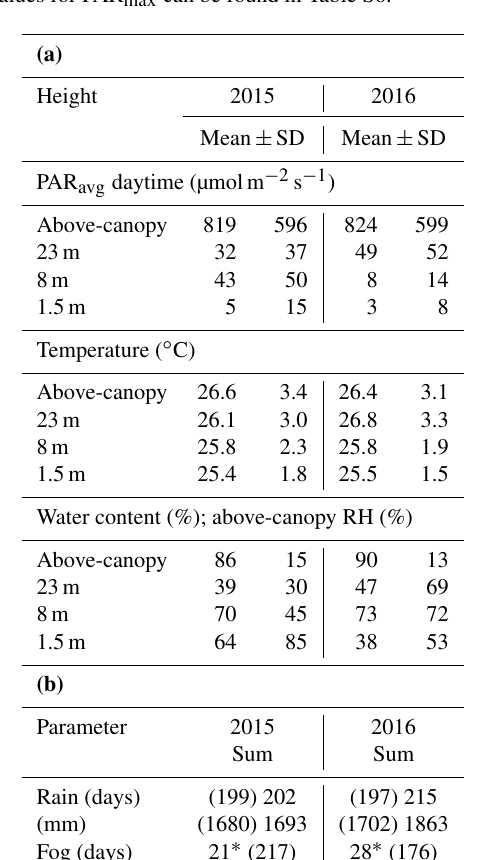
Table 1. Annual mean values and standard deviations ( ± SD) of mean daytime photosynthetically active radiation (PAR avg ), tem- perature, and water content (WC) of bryophytes at the three height levels and above the canopy (a) . Annual sum of rain and fog days as well as the annual sum of rain (b) . Mean values were calculated from 30min intervals. Due to data gaps in the measured rain (shown in brackets), missing values were also extrapolated from existing data as described in the methods section (values behind the brack- ets). Values for PAR max can be found in Table